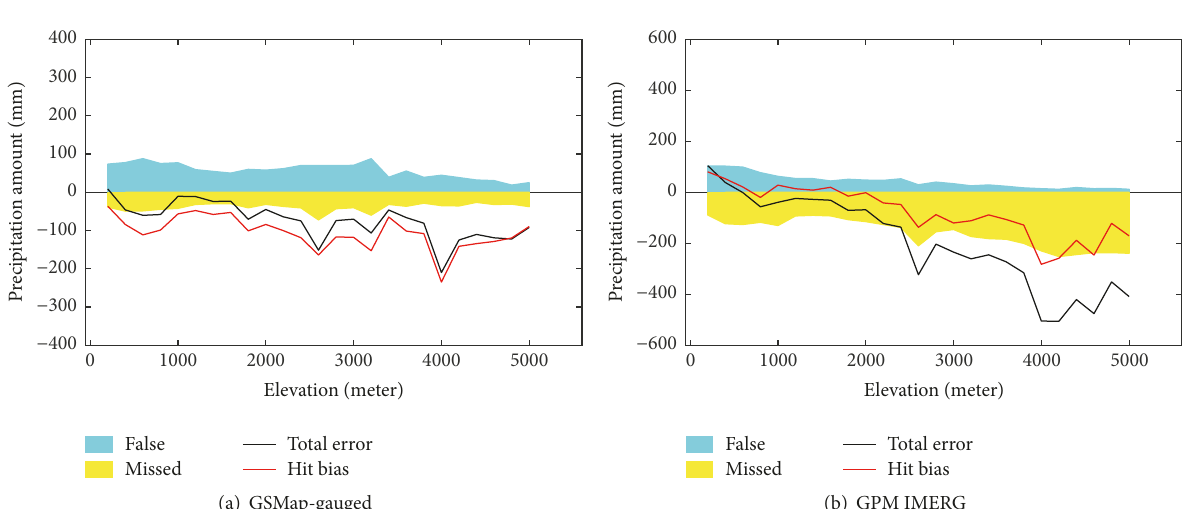
Figure 5: Variations of the error components for both satellite products by elevation over the total study period from April 2014 to March